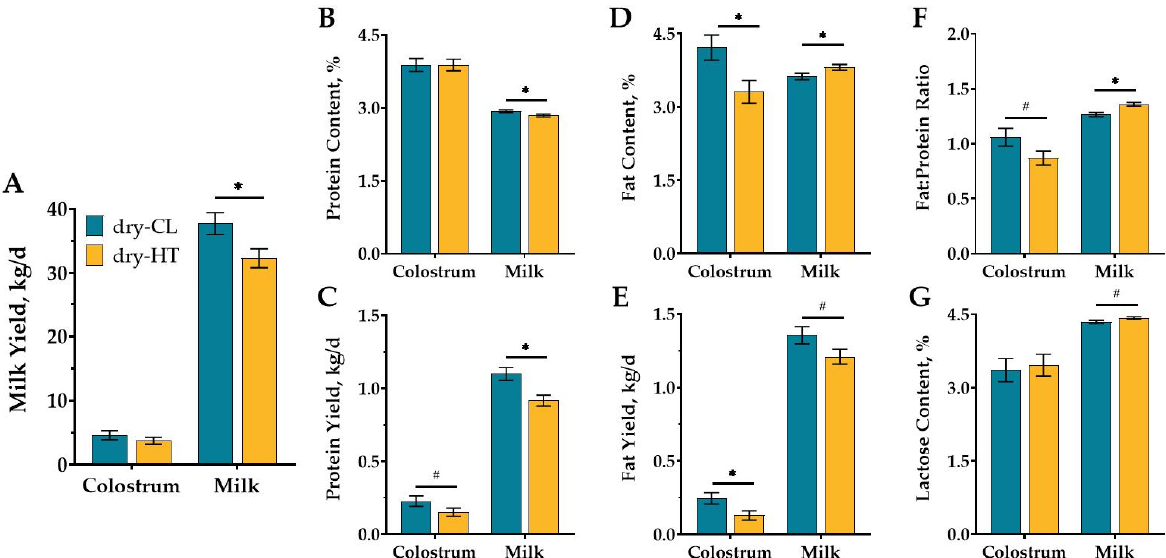
Figure 1. Effect of dry period heat stress on milk yield and composition. Multiparous Holstein cows were exposed to dry period heat stress (dry-HT, shade only, n = 12) or cooling (dry-CL, shade, fans, and water soakers, n = 12) for 46 days before calving. After calving, all cows were actively cooled and colostrum and milk yield ( A ) and composition (i.e., protein ( B , C ), fat ( D , E ), fat:protein ratio ( F ) and lactose ( G )) were measured daily and averaged weekly in AfiFarm up to 210 DIM. Composition is reported as content (%), ratio, or yield (kg/day; calculated from milk yield). All data are presented as least square means ± standard error of the treatment. * indicates p ≤ 0.05; # indicates 0.05 < p ≤ 0.10. Table 1. Effect of dry period heat stress on milk protein profile during lactation. Cows were exposed to dry period heat stress (dry-HT, n = 6) or cooling (dry-CL, n = 6) for 46 days pre-calving. Milk was collected at 14, 42, and 84 days in milk (DIM) and analyzed for milk protein fractions. Data are presented as least square means ± standard error of the treatment